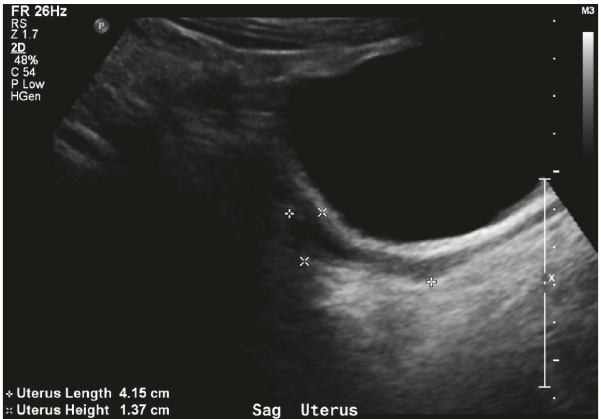
Figure 2: Transabdominal ultrasound of